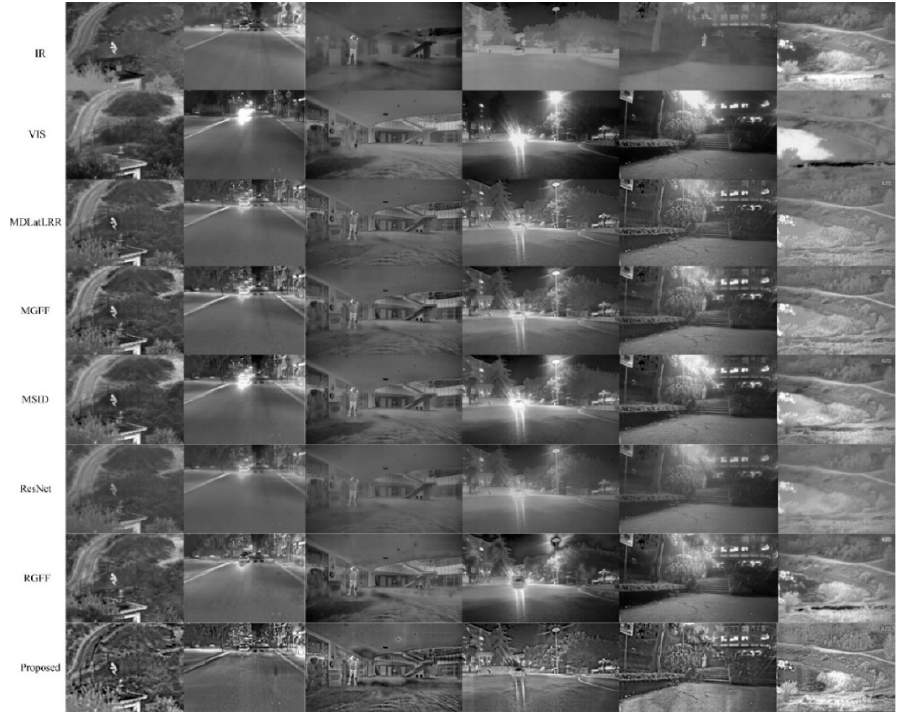
Figure 4. The other six pairs of fused images obtained by six different methods.